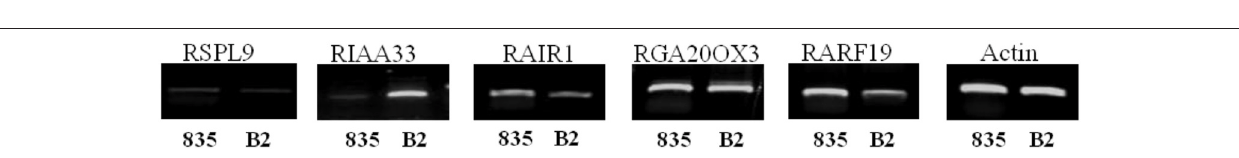
genetic factors, moreover, the EL and RD traits are relatively low value that can be easily influenced by the environment ( Table 1